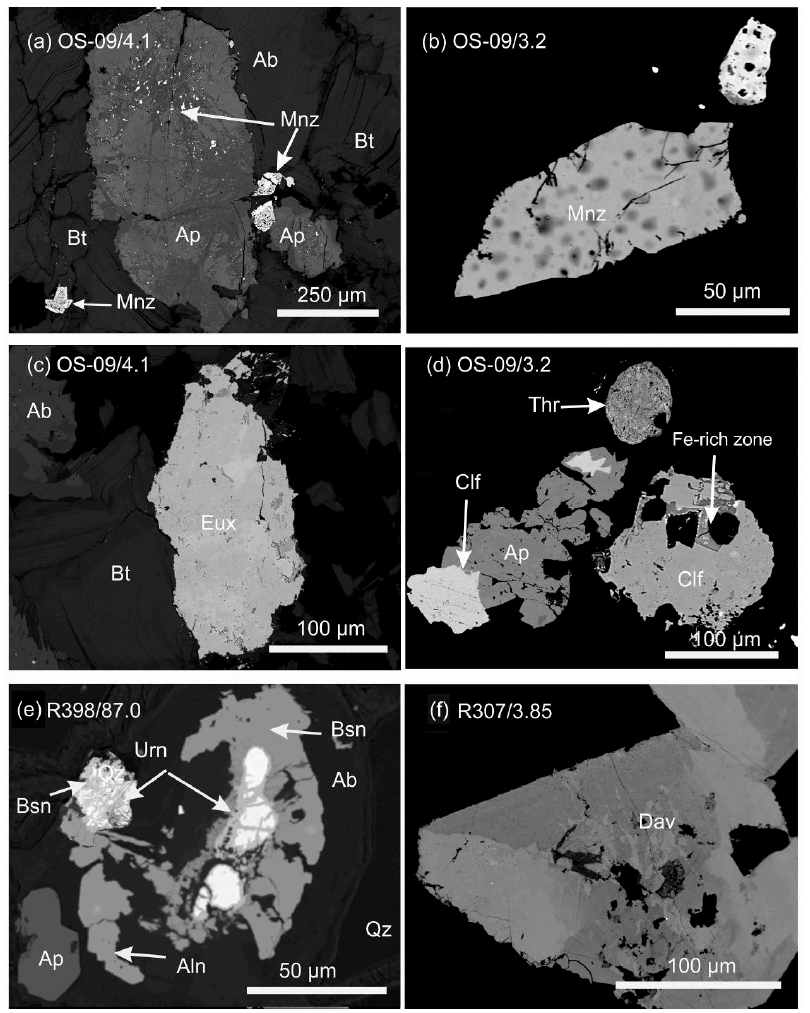
Figure 12. Back-scattered electron images REE-bearing minerals in Kuusamo Belt; ( a ) Monazite (Mnz) as inclusions within apatite (Ap); ( b ) Porous monazite; ( c ) Euxenite (Eux) in association with albite (Ab) and biotite (Bt); ( d ) Sub rounded Fe-columbite (Clf) associated with apatite (Ap) and thorite (Thr); ( e ) Uraninite (Urn) grains surrounded by halos of bastnäsite (Bsn) and allanite (Aln); ( f ) Crystalline to partially damaged davidite (Dav), a member of the crichtonite mineral group and also showing patchy chemical zoning.